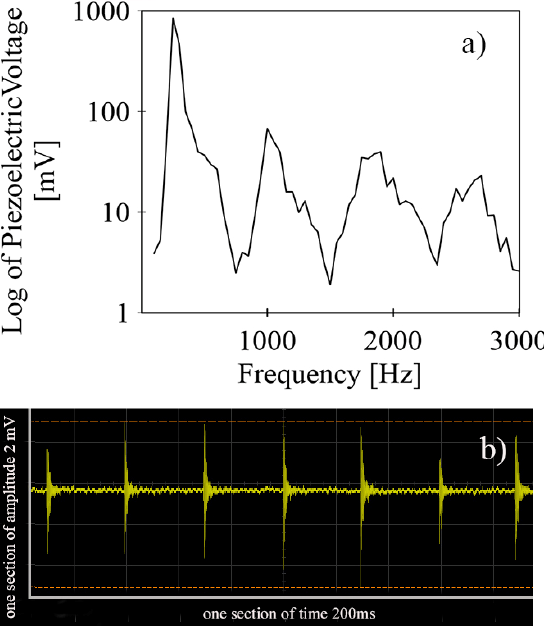
Figure 5. ( a ) Frequency spectra of generated piezoelectric voltage by a PVDF membrane as a response to sound generated by the speaker in a frequency range 100–3000 Hz, ( b ) membrane piezoelectric response to seven handclaps. (Note: one section is represented by the range between two grid lines on the graph background represented by thin white